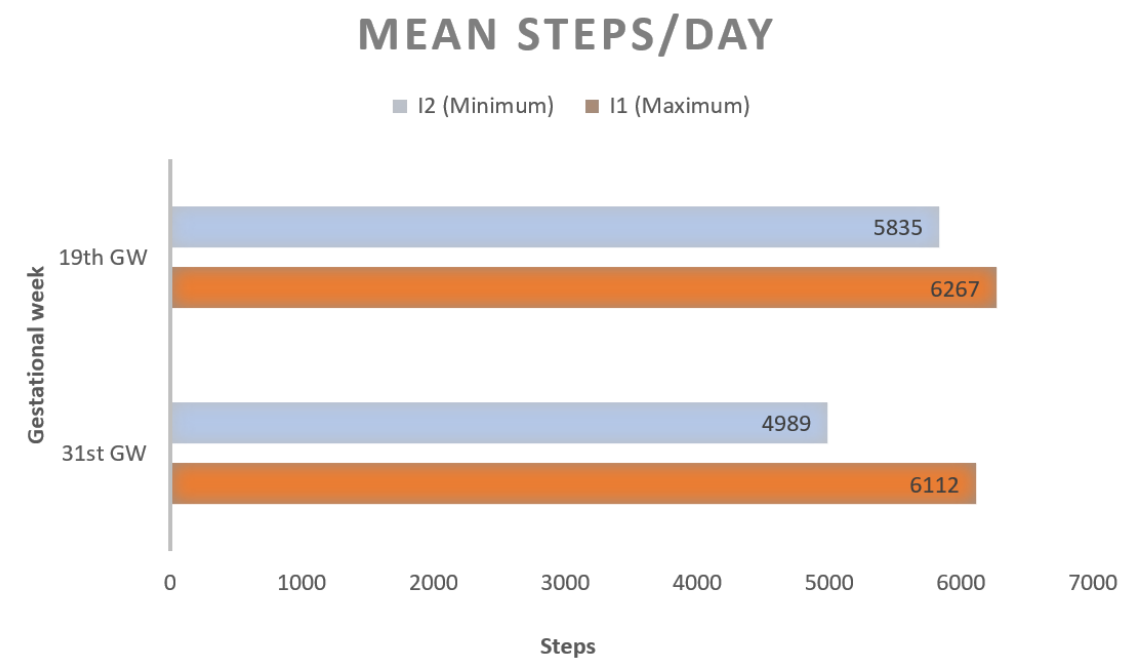
Figure 2. Mean steps/day at 19th and 31st GW.